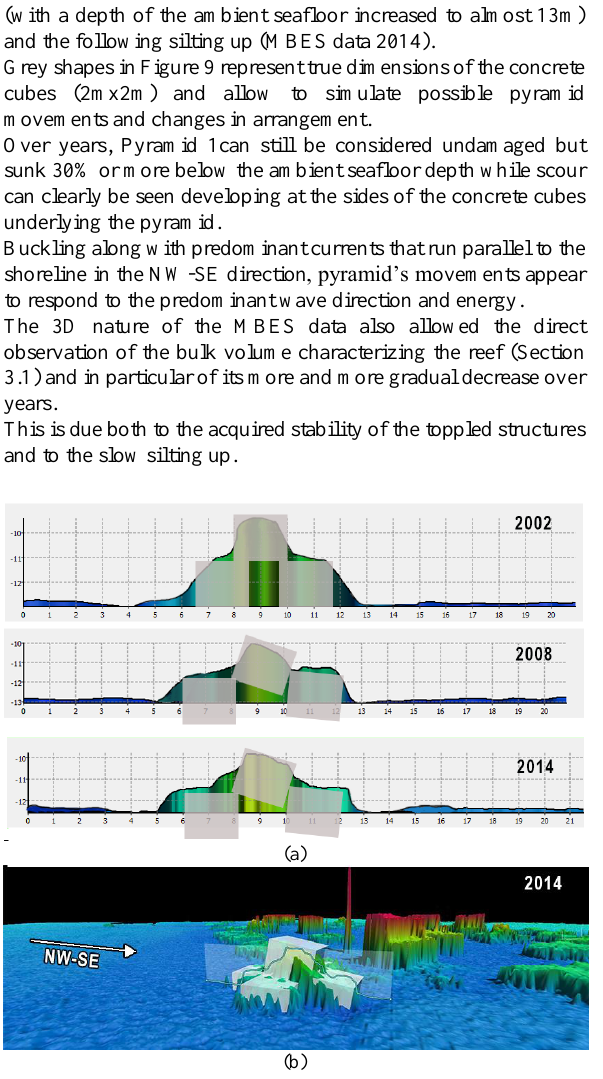
Figure 9. Progression of AR Pyramid 1 burial/integrity over chosen years (a). Profiles were taken along NW-SE direction (b)